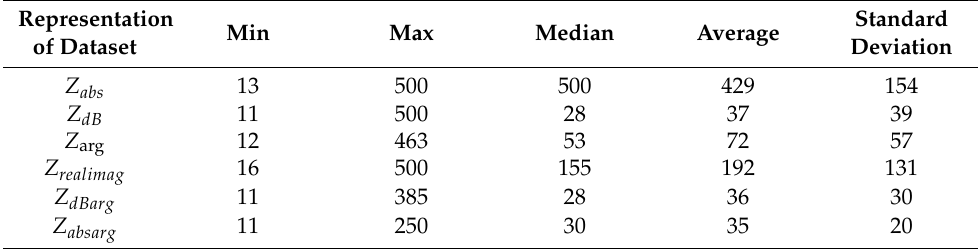
Table 1. Iterations statistics for different representations of the DFRD